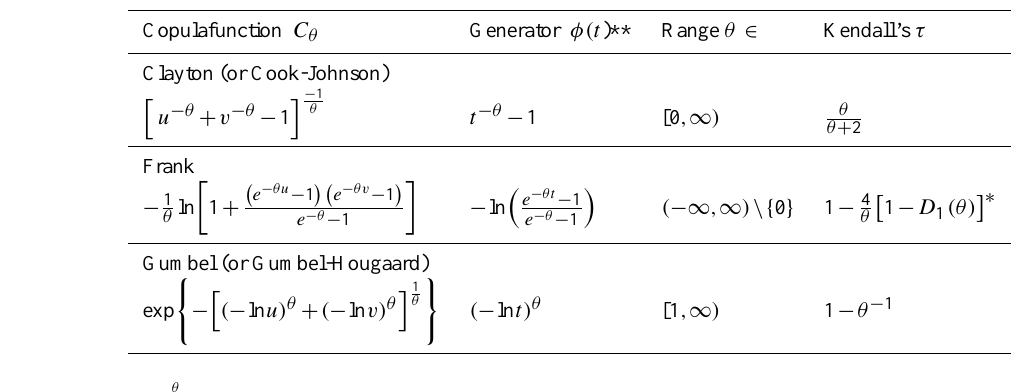
Table 1. Archimedean Copula functions considered for the present study and their generator functions, ranges for the Copula parameters θ and connections to Kendall’s τ .